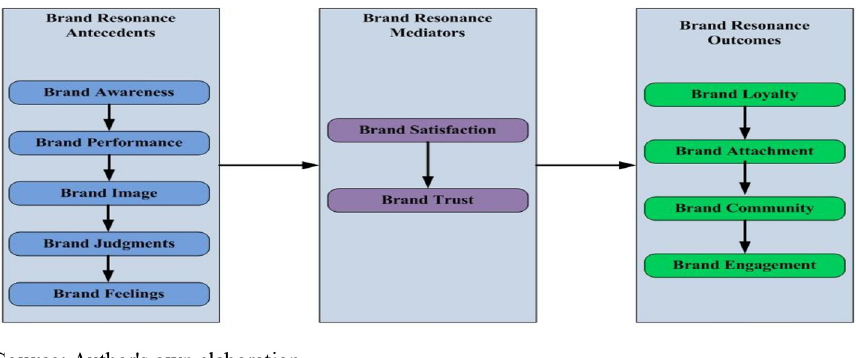
Figure 1. Conceptual model